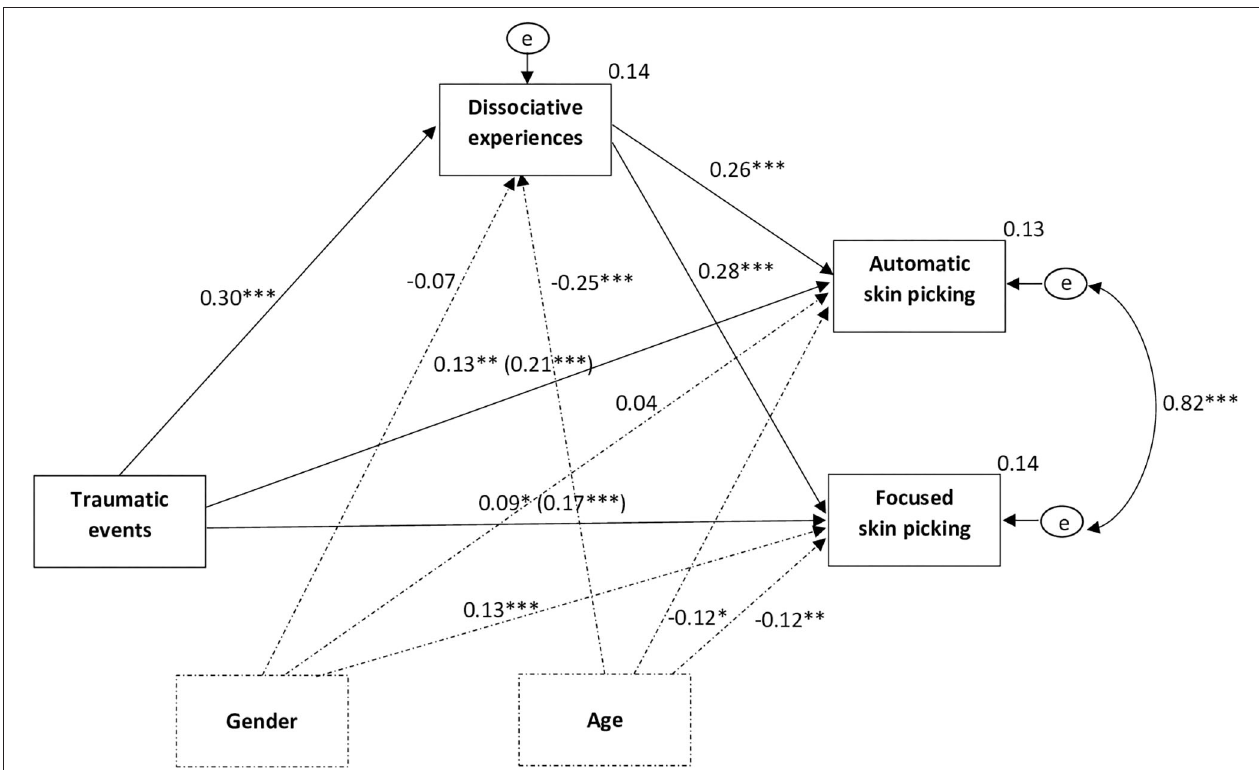
FIGURE 1 | Dissociative experiences mediate the relationship between traumatic events and automatic and focused skin-picking. N = 594, * p < 0.05, ** p < 0.01, *** p < 0.001; gender and age were controlled for in the analysis; exogenous variables were allowed to covary; the effects on the direct path from traumatic events to automatic and focused skin-picking depict the direct effect and the (total effect) accordingly; indirect effect of traumatic life events on automatic skin-picking via dissociative tendencies: β = 0.08; CI: 0.05 to CI = 0.11, p < 0.001; indirect effect of traumatic life events on focused skin-picking via dissociative tendencies: β = 0.09; 95%CI:0.05 to 0.13, p < 0.001.